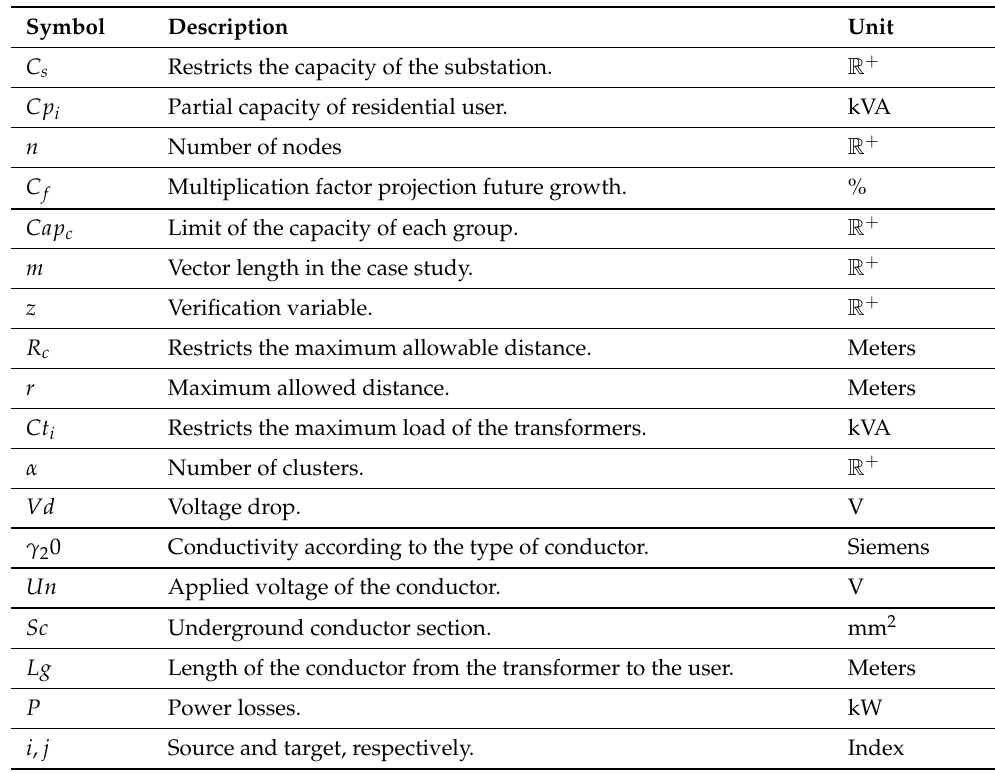
Table 4. Variables related to the